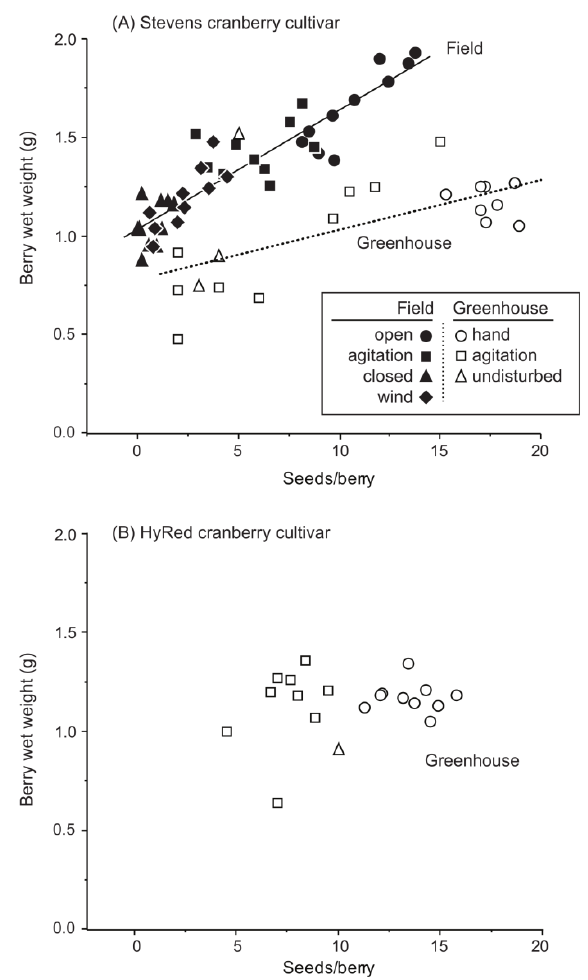
F IGURE 3: Relationship between berry weight (g wet weight) and seeds per berry for the cranberry cultivars (A) “Stevens” and (B) “HyRed”, for field (solid symbols) and greenhouse (hollow symbols)